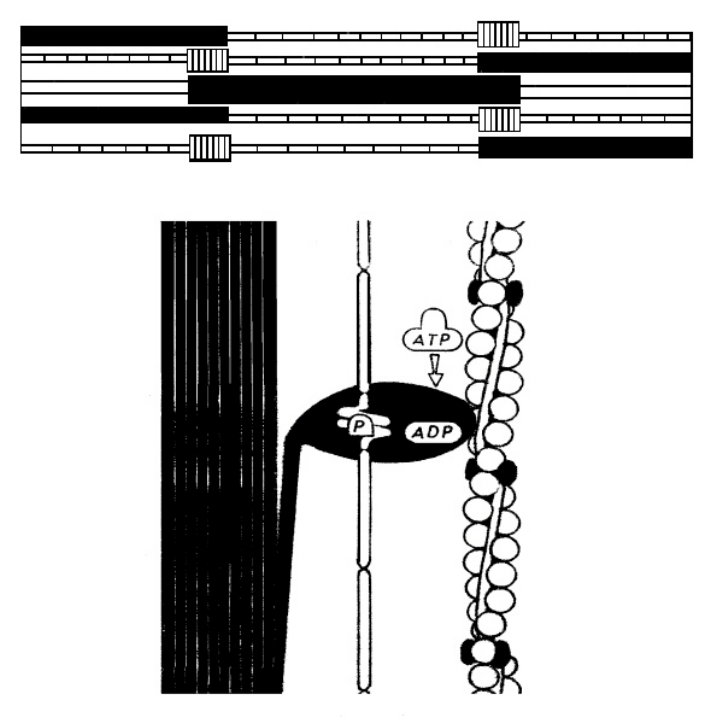
FIGURE 2. Schematic representation of the proposed N-filaments[2] made by serially linked modules able to fold as a consequence of ATP splitting in the overlap region of the thin and thick filaments.